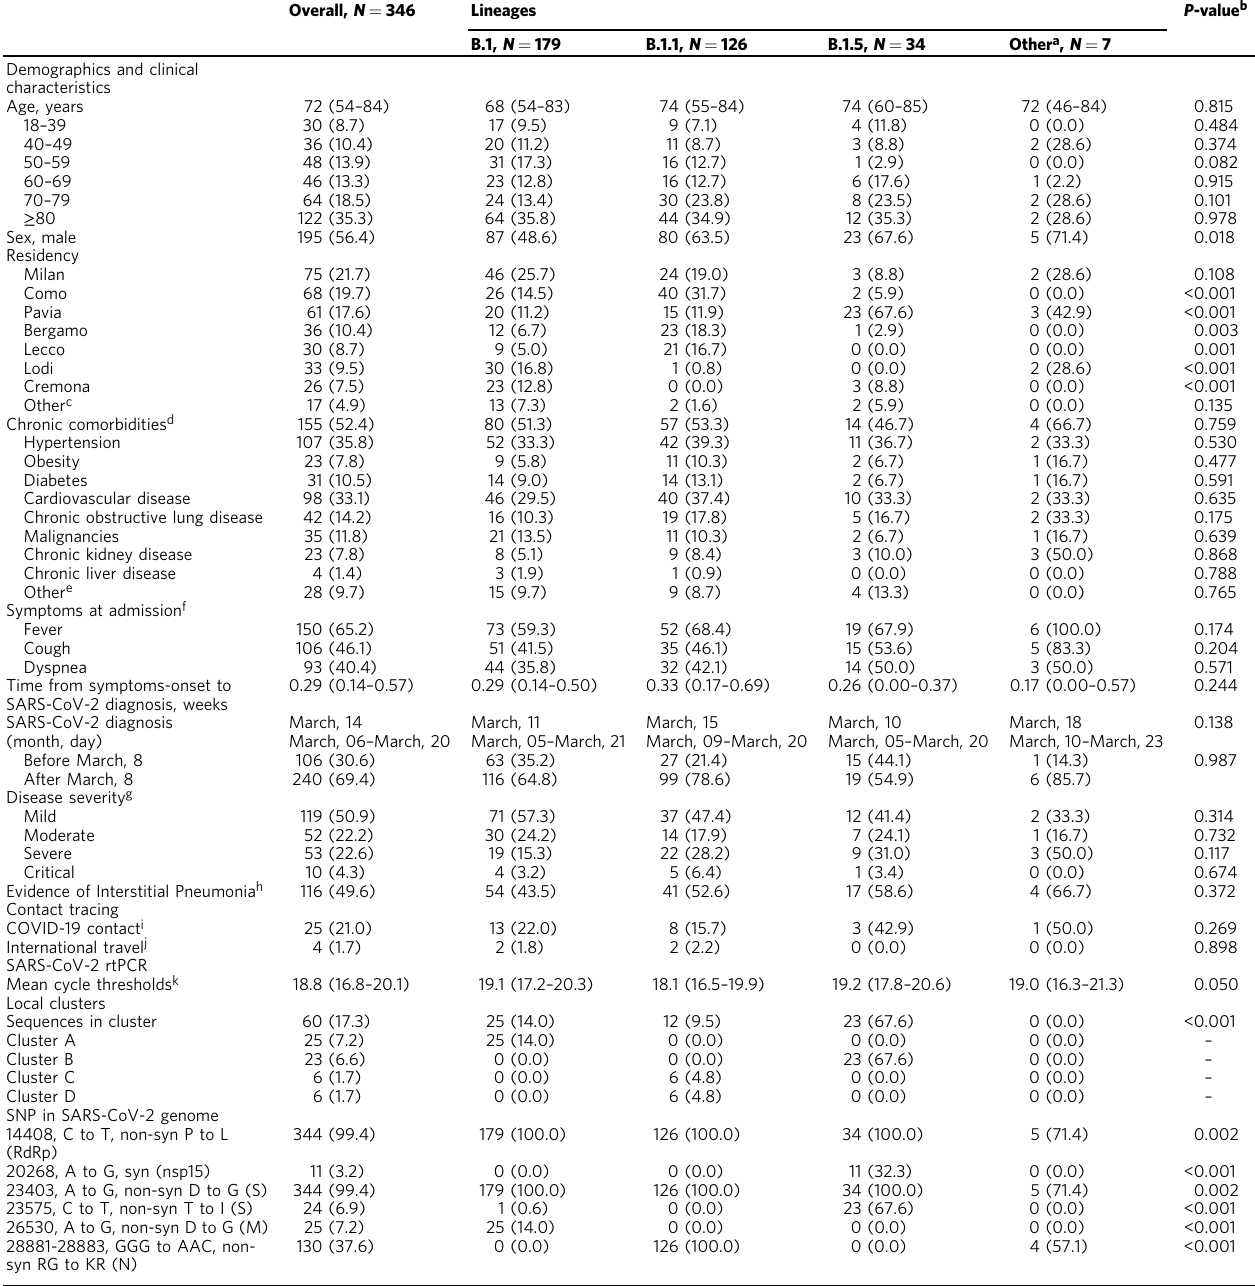
Table 1 Demographic and clinical fi ndings of the 346 SARS-CoV-2-infected patients according to